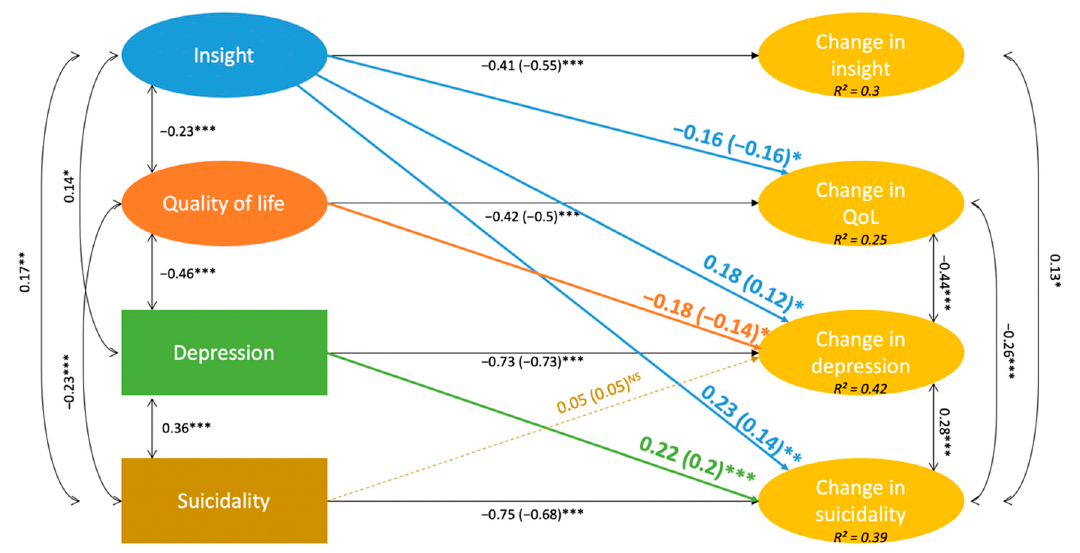
Figure 2. Simplified diagram of the final model. Single-headed arrows are regression paths with unstandardized (and standardized) coefficients. Double-headed arrows are covariances with standardized coefficients. For readability, only significant paths are shown. R² is the amount of explained variance of endogenous variables. Significance levels: * p < 0.05, ** p < 0.01, *** p < 0.001.